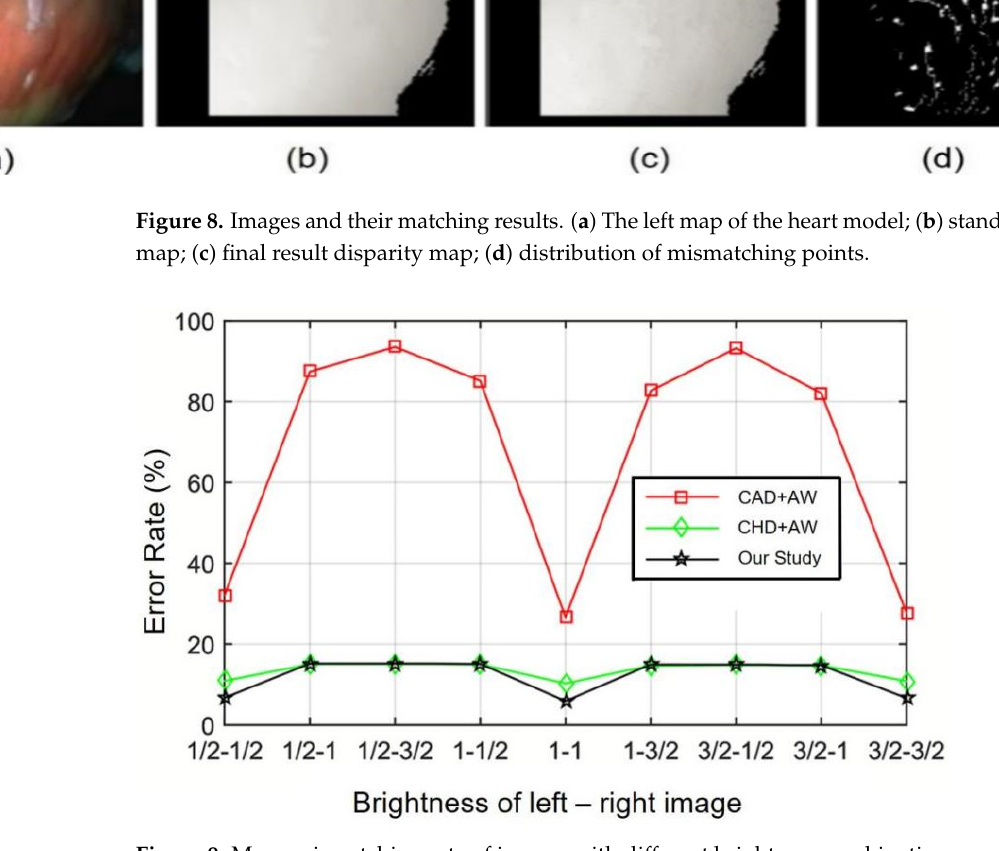
Figure 9. Mean mismatching rate of images with different brightness combinations. The stereo matching algorithm in this paper was used to perform the stereo matching operation on the actual stereo images of cardiac soft tissue corrected by the stereo endoscope, and the final parallax image was obtained with the left image as the reference image, as shown in Figure